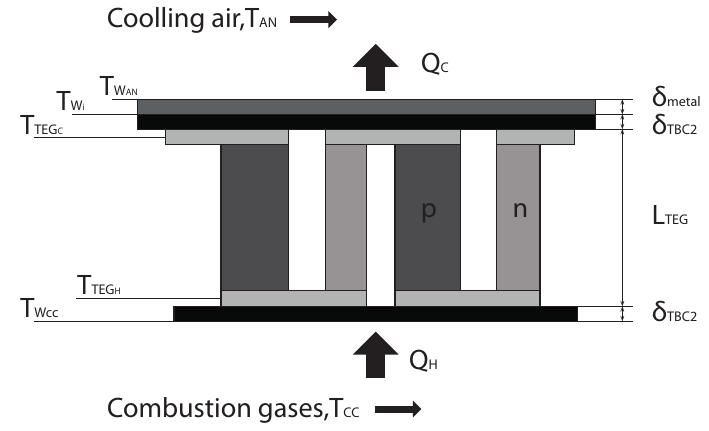
Figure 6. Sketch of the combustor liner wall, equipped with the TEG and the respective computation stations for the solution of the heat balance